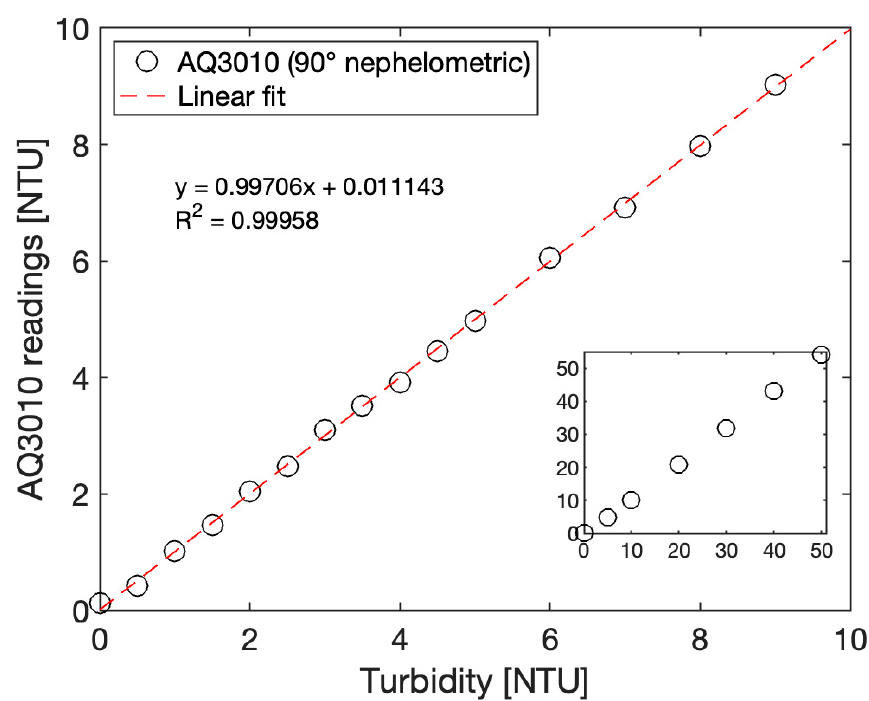
Figure 6. Graph of a calibrated Thermo Scientific Aquafast AQ3010 Turbidity meter to Formazin solutions from 0 to 10 NTU (main graph) and 0 to 50 NTU (inset).